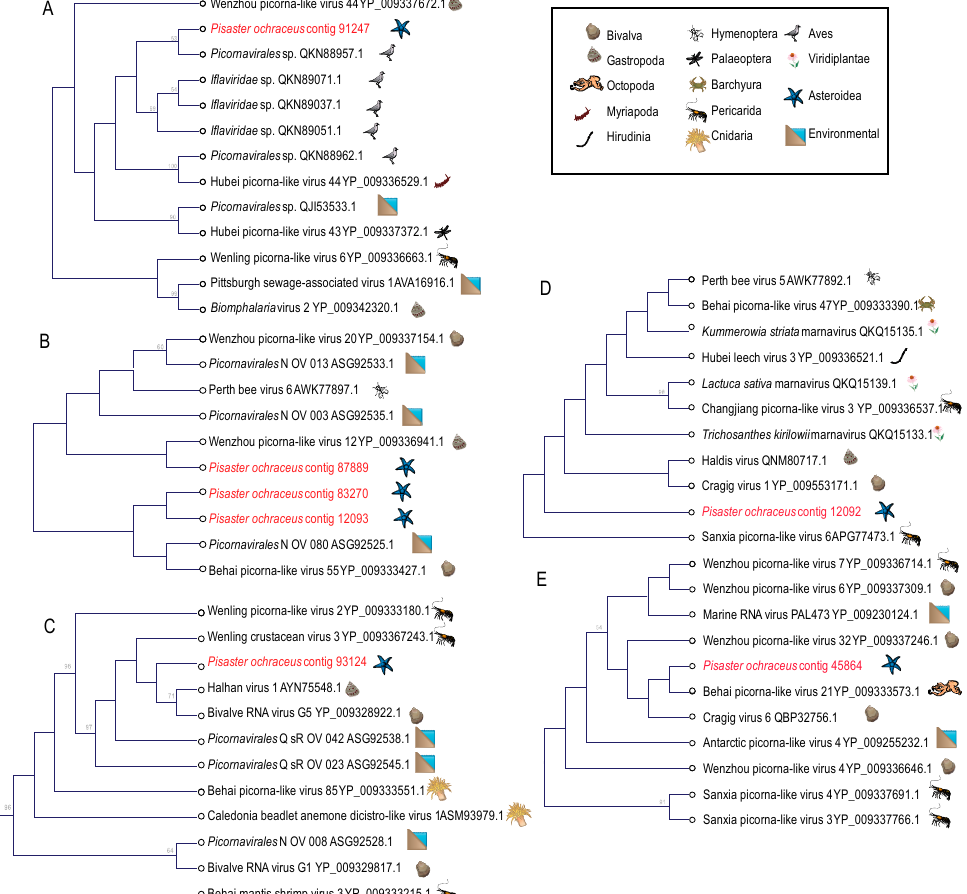
Figure 4. Phylogenetic representations of Picornavirales -like genome fragments recovered from Pisaster ochraceus . The cladograms were constructed based on a 98 amino acid alignment of the RNA dependent RNA polymerase gene ( A ), a 187 amino acid alignment of the rhv-like capsid domain ( B ), a 160 amino acid alignment of the RNA helicase domain ( C ) and 193 amino acid of the RNA dependent RNA polymerase gene ( D,E ) and performed separately for overlapping regions including best matches at NCBI. Trees were constructed by Neighbor Joining and based on Jukes-Cantor distance in the CLC Genomics Workbench 4.0 (Qiagen). Bootstrap values >50% (based on 1000 iterations) are indicated above nodes. The host identity is indicated by symbols next to branch labels. An additional phylogenetic representation of each tree based on maximum likelihood is presented in Figure S3. Nodaviruses (+ssRNA) represent significant pathogens of marine vertebrates (reviewed in [48,49]) and invertebrates [50] and are frequently recovered in grossly normal marine invertebrates [51–54]. Two viral contigs matching most closely nodaviruses by BLASTx (Figure S4) were recovered in our survey. Phylogenetic analyses placed these most similar to nodaviruses recovered from cnidarians, nematodes and arthropods as part of transcriptomic viral discovery efforts [22] (Figure 5). Nodavirus-like genome fragments were identified in the asteroid Pycnopodia helianthoides [2] and were present in wasting-affected Pisaster ochraceus libraries prepared from the Olympic National Park in 2013 (NCBI BioProject SAMN15704856; tBLASTx e < 1 × 10 − 20 ) [5], however were absent in a RNA viral metagenomic survey of holothurians [17]. Our observation of nodavirus genome fragments in asteroids extend the known host range of the Nodamuvirales .